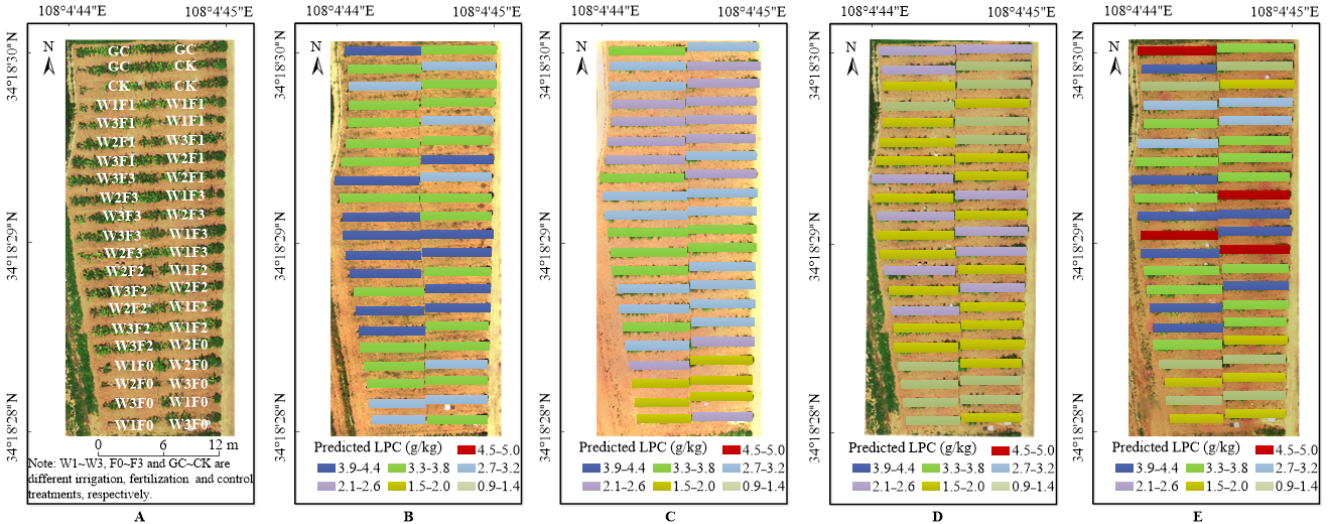
Figure 8. ( A ) Distribution map of grape with different treatments based on UAV image (22 June 2021). ( B ) LPC distribution map of grape in the new shoot growth stage based on UAV image (8 May 2021). ( C ) LPC distribution map of grape in the flowering stage based on UAV image (31 May 2021). ( D ) LPC distribution map of grape in the fruit expansion stage based on UAV image (22 June 2021). ( E ) LPC distribution map of grape in the veraison and maturity stage based on UAV image (23 July 2021).